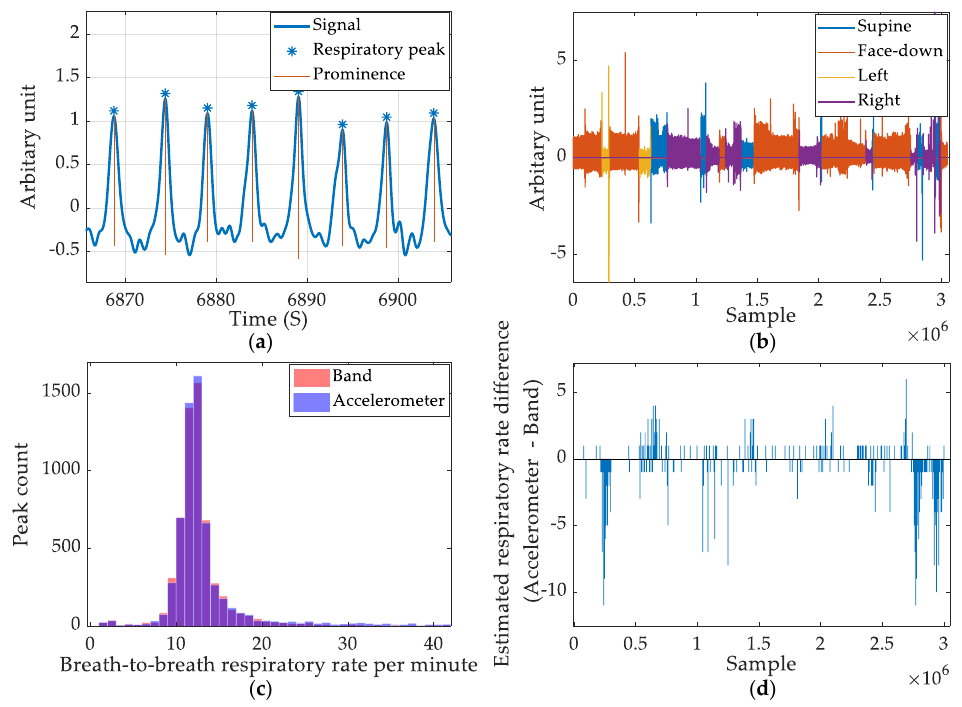
Figure 11. Summary of accelerometer-based respiratory rate estimation. ( a ) The respiratory signal captured by accelerometer and detected peaks. ( b ) The color-coded respiratory signal captured in a full night’s recording. ( c ) Breath-to-breath respiratory rate count comparison between accelerometer and band signal. ( d ) The estimated respiratory rate difference between the accelerometer and band data.